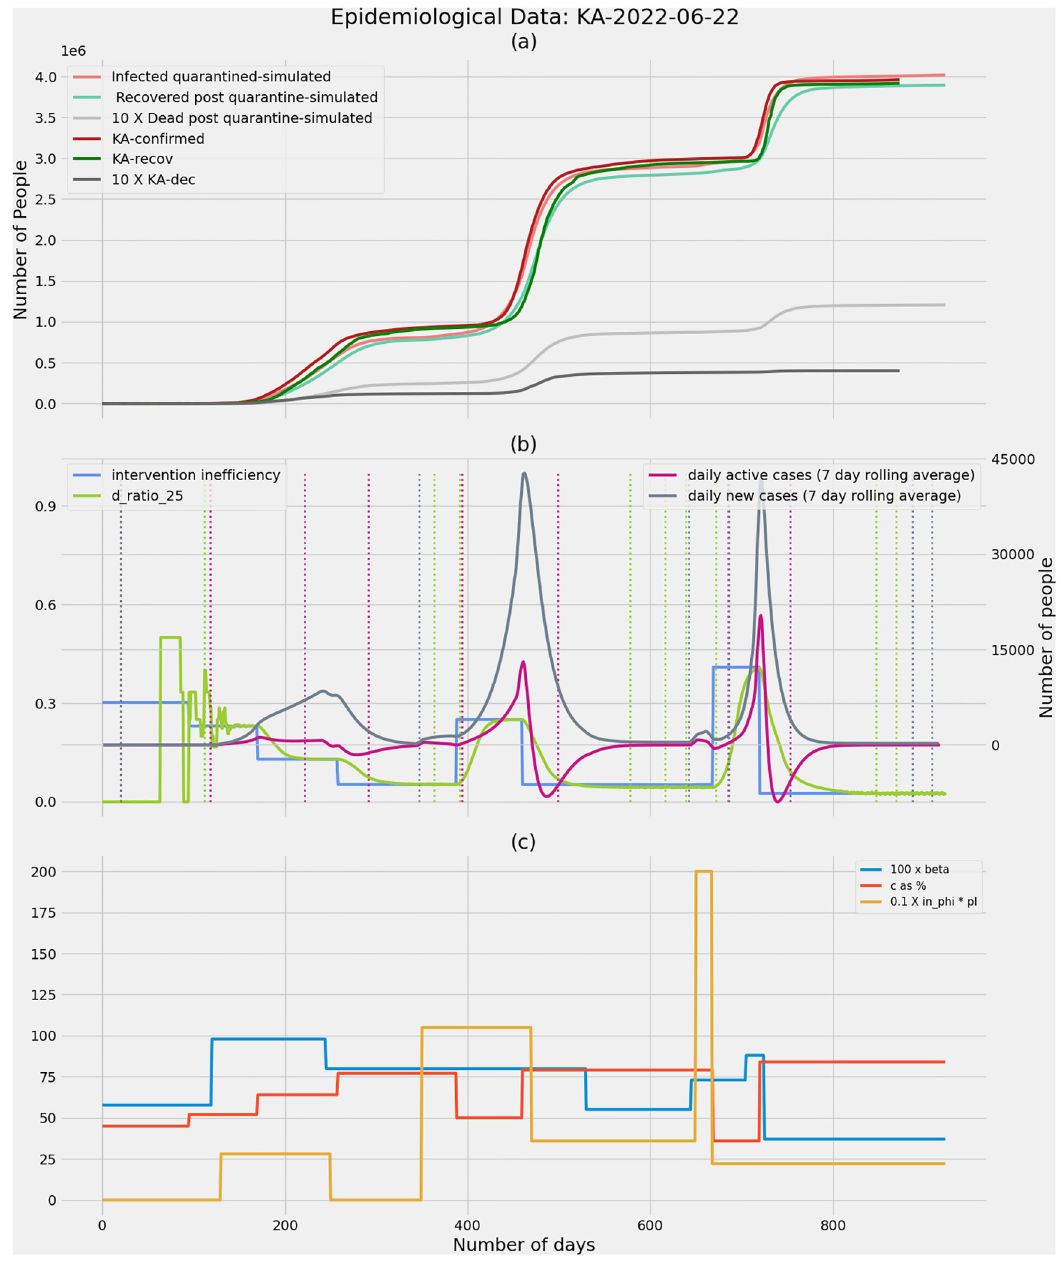
Fig 7. Karnataka as on 22nd June 2022. (a) Real COVID-19 data and simulated data showing confirmed cases, recoveries and deaths. It is observed that simulations match the real case growth to a great extent. (b) The intervention inefficiency underlying the epidemic is plotted along with the ratio of deaths from undetected infections to total number of deaths (D ratio ), daily new cases and active cases. The dashed vertical lines correspond to the potential time points when an intervention can be made based on the respectively coloured D ratio , daily active cases and daily new cases. D ratio predicts an upcoming wave ahead of other metrics when the wave is precipitated due to a drop in efficiency (decreasing values of ‘c’—the fraction of infections detected through contact tracing). (c) The model parameters beta, fraction of infections that get detected through contact tracing—‘c’, the fraction of infections spread through migrant population—’in phi � pI’ are tuned to fit the model to real